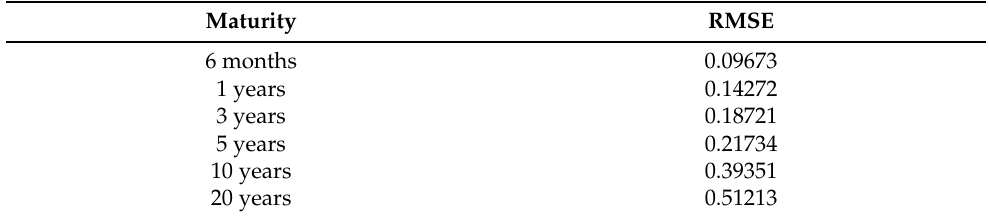
Table 1. The root mean-squared error for each considered maturity. The last error is for the out-of- sample forecast of the 20-year yield.